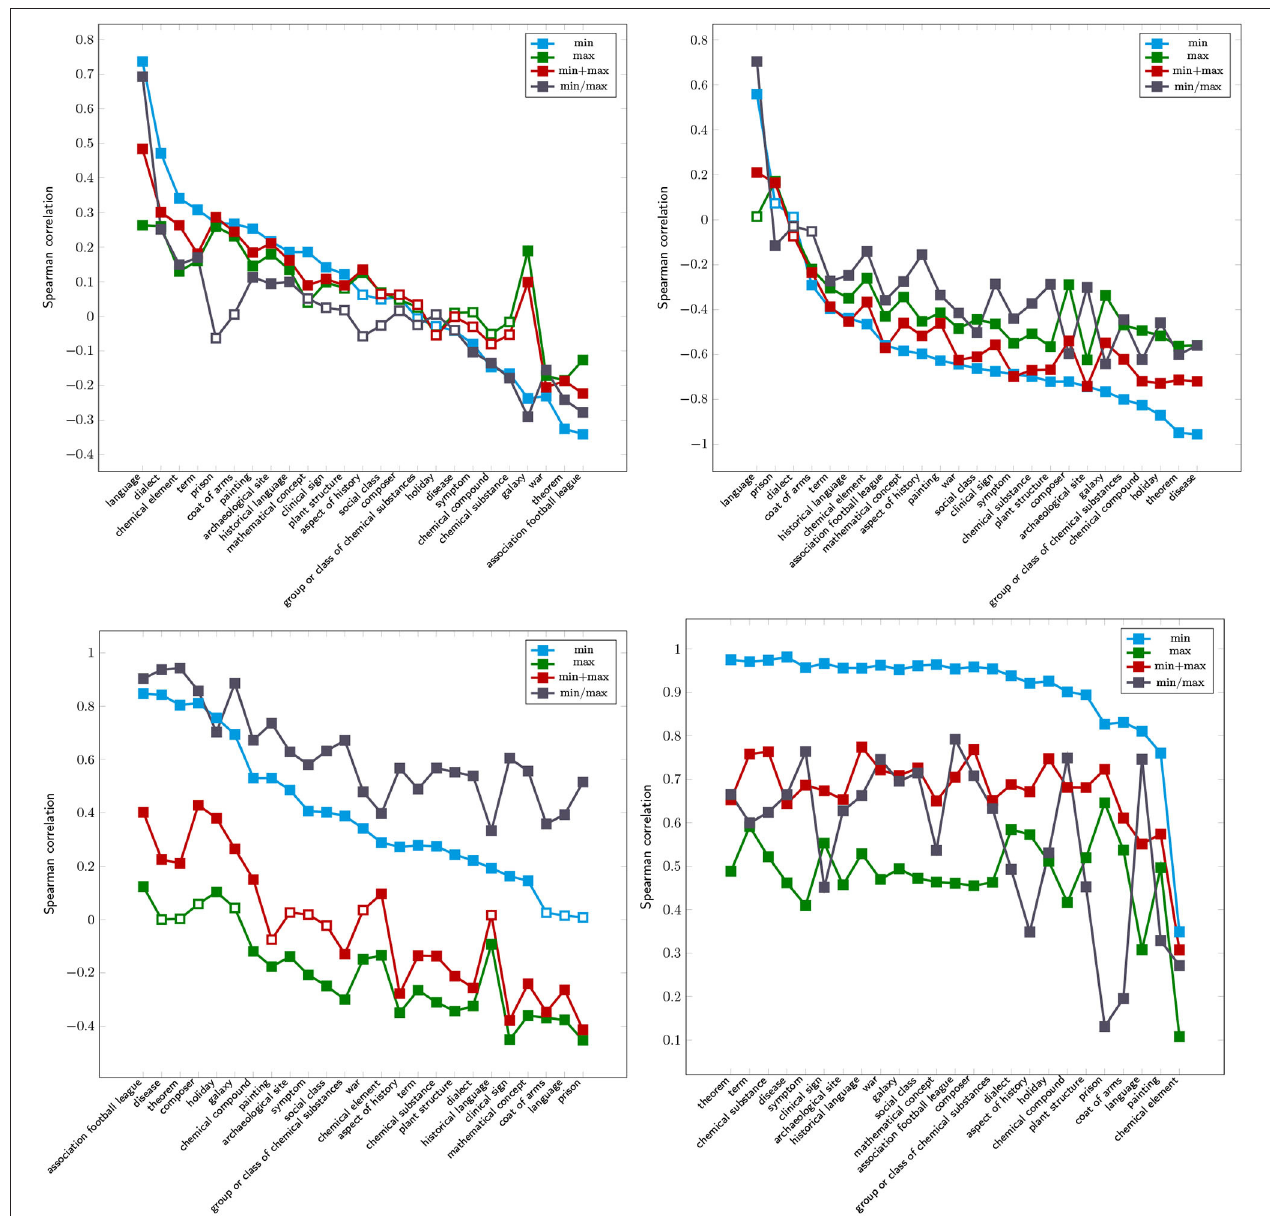
FIGURE 10 | Rank correlation of the sizes [calculated as min (blue, used as a reference in descending order of correlation), max (green), sum (red), and ratio (gray)] of paired networks (INs) and their similarities computed per subject area using four measures: Upper left : SV2 (thematic intratextual similarity), Upper right : SV4-DeltaCon (intertextual similarity), Lower left : (SV4-GES), Lower right : (SV4-CGS). Filled boxes indicate significant correlations ( p <